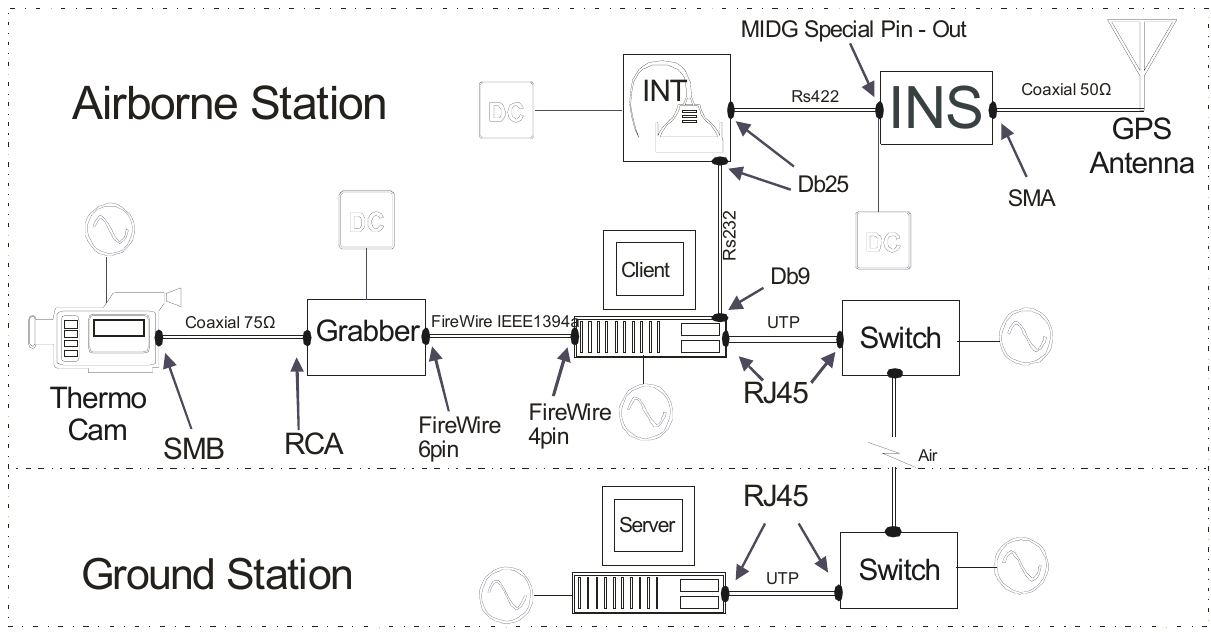
Figure 4 . The SITHON airborne imaging system